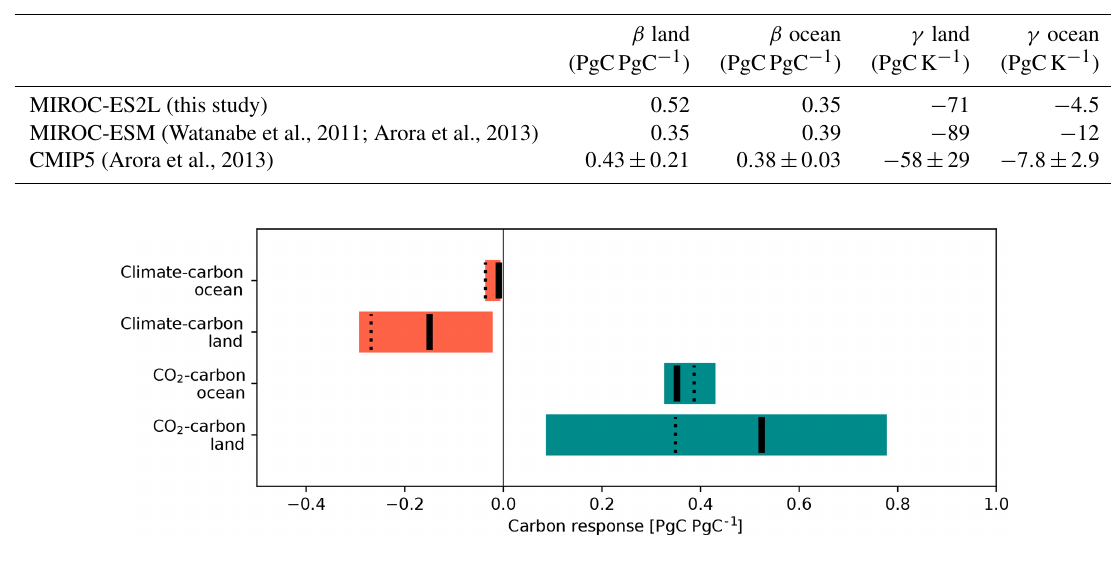
Figure 18. Comparison of the strength of CO 2 –carbon and climate–carbon feedbacks between MIROC-ES2L and the CMIP5 models eval- uated using the 1PPY, 1PPY-BGC, and 1PPY-RAD experiments. Vertical solid and dotted black bars represent MIROC-ES2L and MIROC- ESM, respectively, and the horizontal bars represent the range of the CMIP5 ESMs (mean ± 1 . 65 σ ). To compare the two types of feedback strength with the same unit, land and ocean carbon storage change were both normalized by dividing the atmospheric carbon change, which corresponds to the u quantity proposed by Gregory et al. (2009): CE = CA (1 + u β + u γ ), where u β = β , u γ = γ × α . If u > 0 ( u < 0), the feedback sign is negative (positive). The calculations were based on the anomaly from the CTL run at the time of a quadrupled CO 2 concentration from the preindustrial condition (i.e., the 140th year of the 1PPY, 1PPY-BGC, and 1PPY-RAD